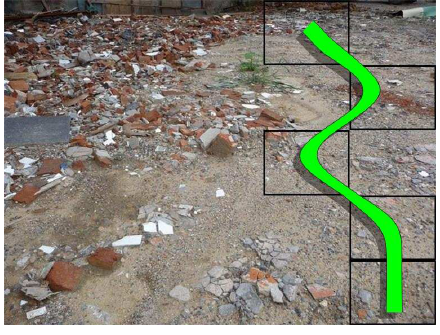
Fig. 14. The original traversability prediction of the experi- ment 2.